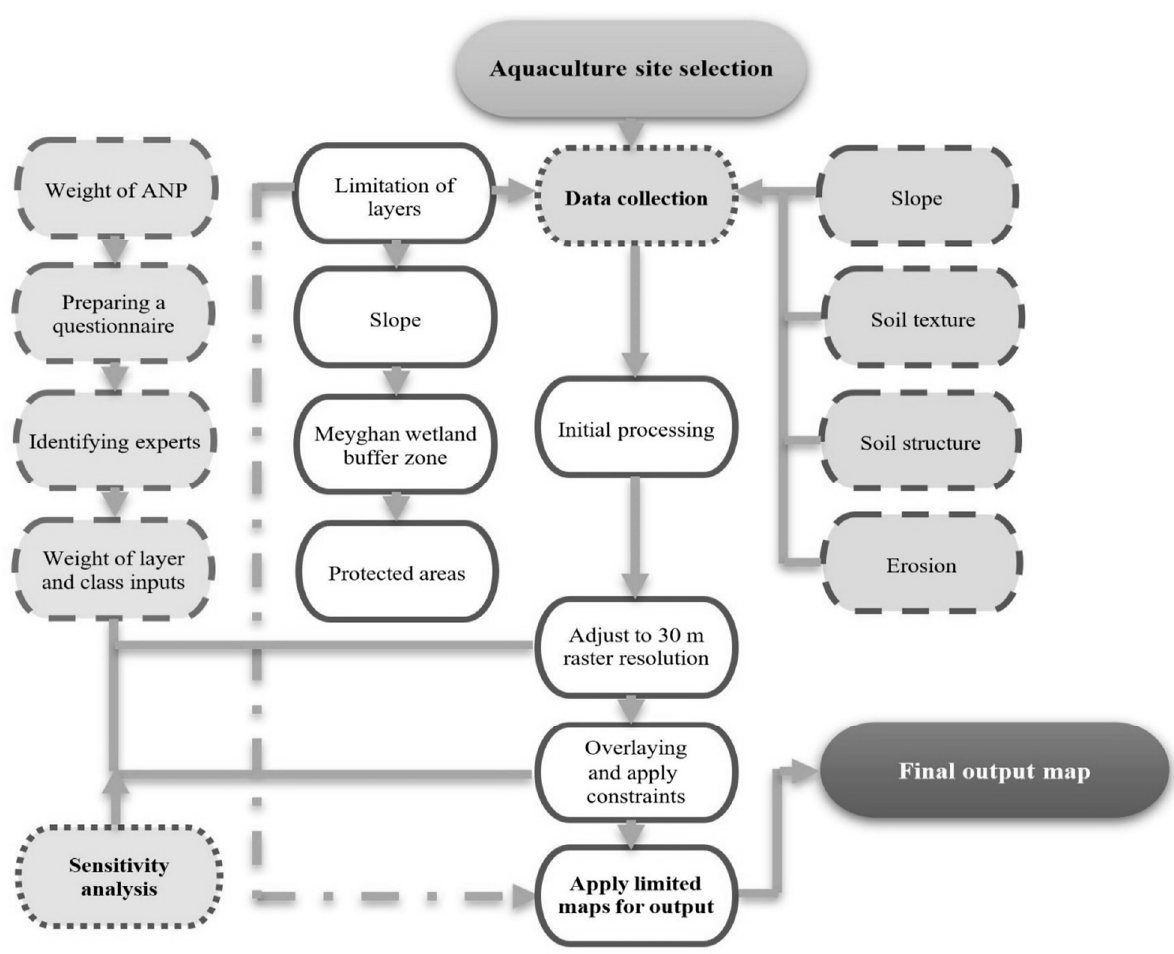
Figure 3. Methodology flowchart.